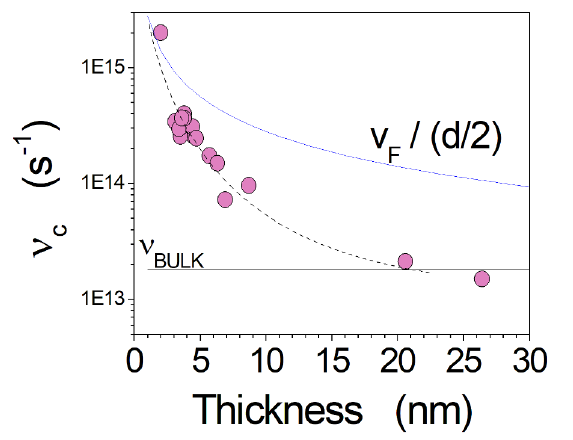
Figure 3. Thickness of all samples, obtained from the simula- tion.